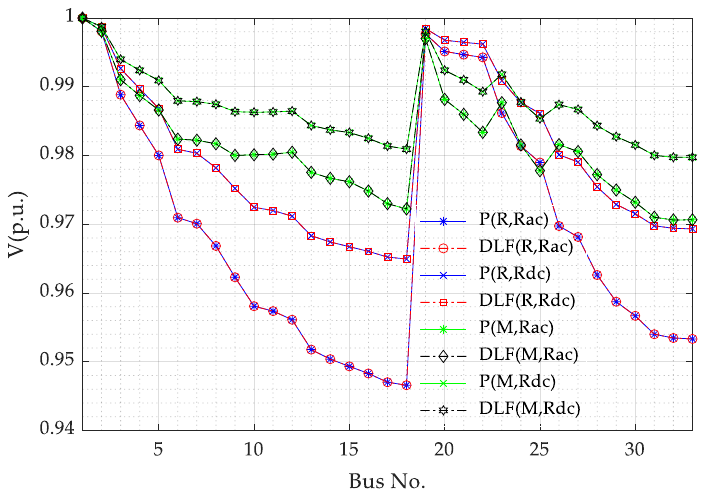
Figure 4. Voltage profile of the 33-node test feeder (Case 1, P = proposed R = radial, M = meshed, DLF = direct load flow).